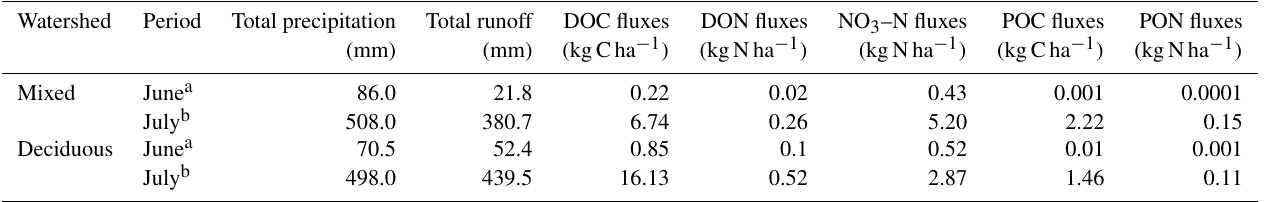
Table 3. Total precipitation, total runoff, and integrated fluxes of dissolved organic carbon (DOC) and nitrogen (DON), nitrate (NO 3 –N), particulate organic carbon (POC), and nitrogen (PON) in June and July 2013. Watershed